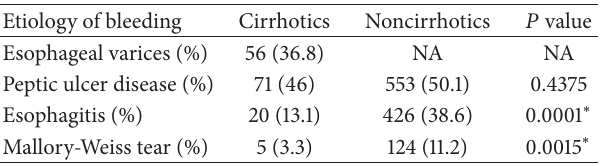
Table 1: Depiction of etiologies of bleeding in cirrhotics and noncirrhotics, respectively.